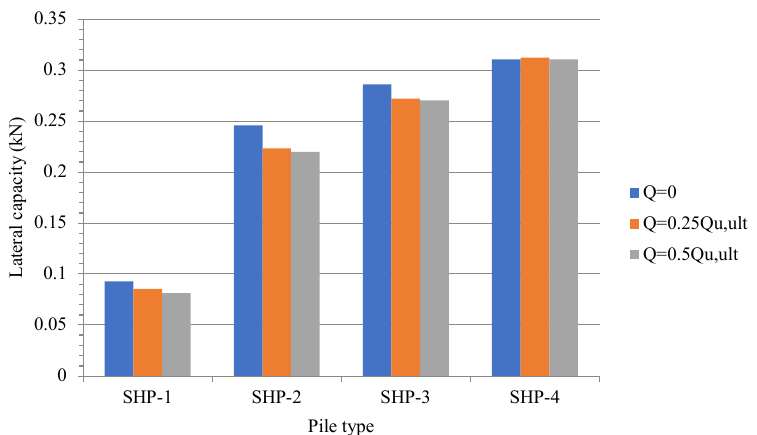
Figure 15. Effect of uplift loading on lateral capacity of helical pile.